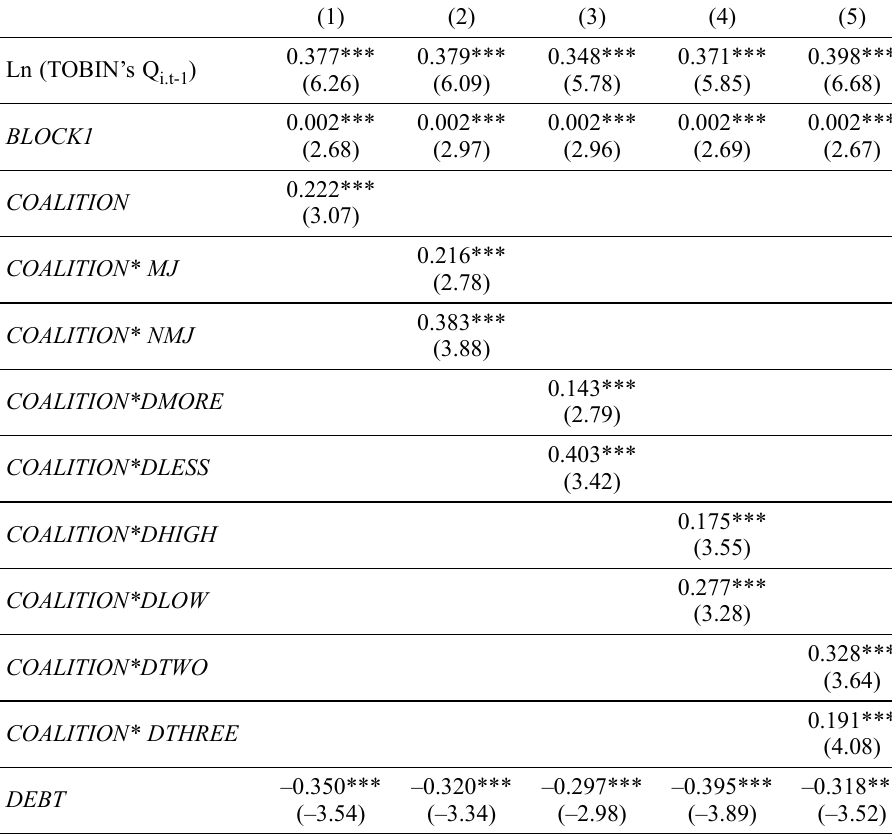
Table 4. Relation between firm value and the contestability effect. Moderating role of ownership concentration and the number of